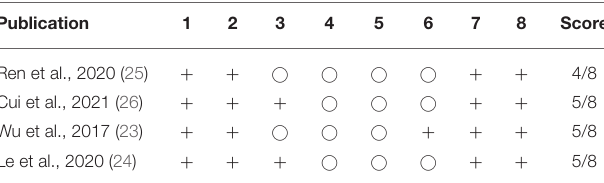
TABLE 3 | Evaluation of the study quality with a modified checklist CAMARADES